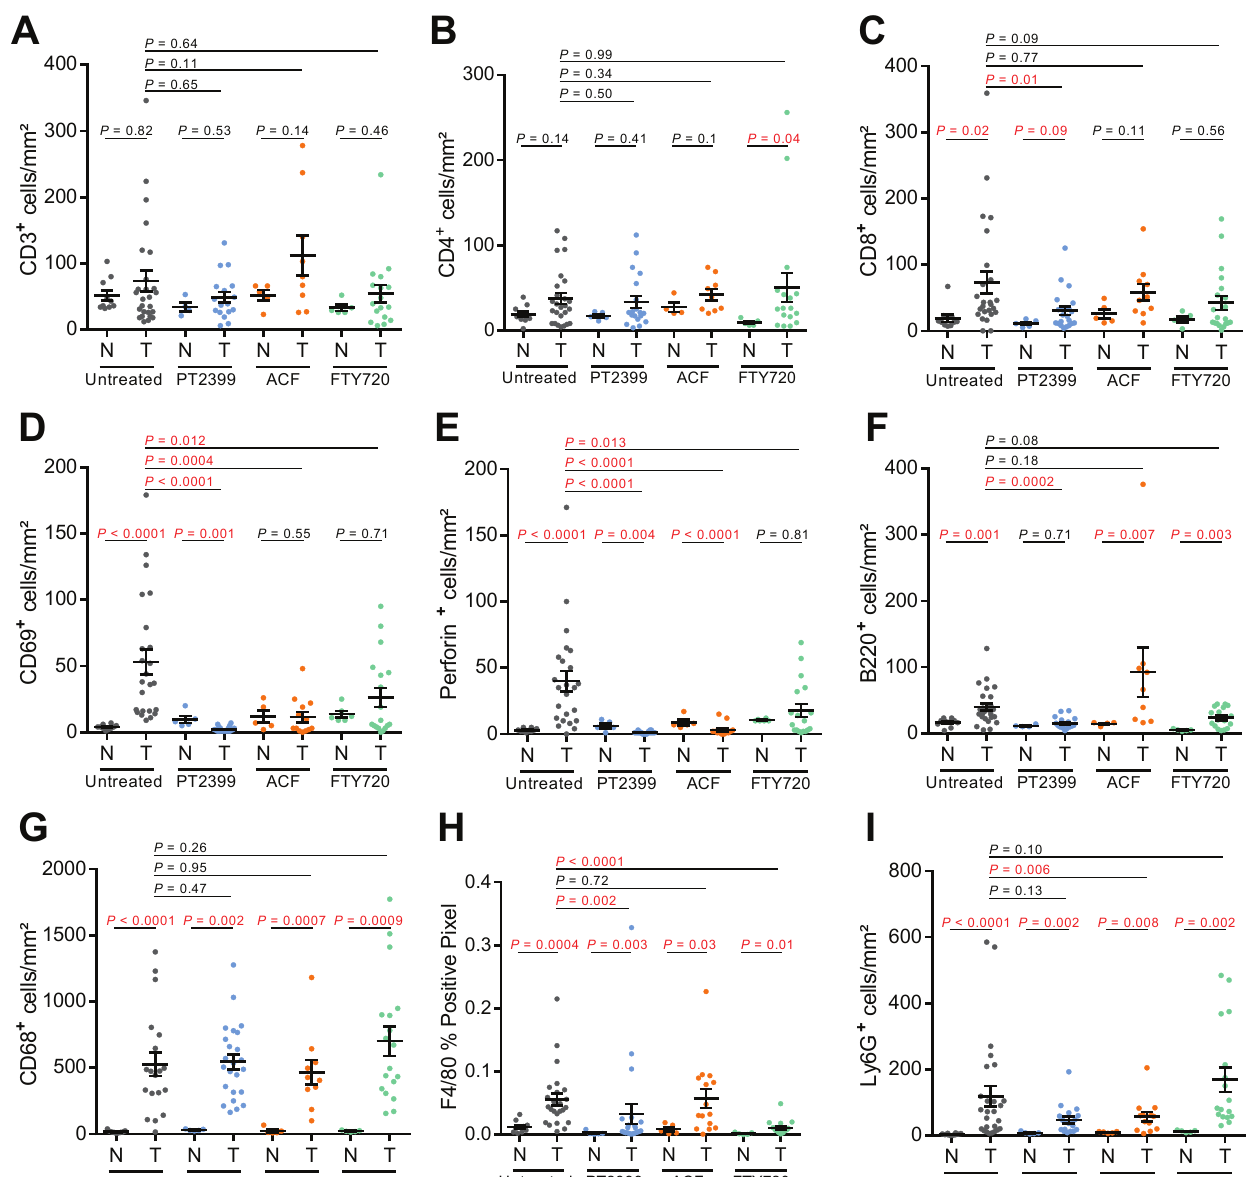
Figure 3. Analyses of the tumor immune microenvironment in therapy treated mice. ( A – I ) Quantification of the densities of immunohistochemically positive cells stained with the indicated antibodies in unaffected normal renal tissue (N) and VpR ccRCC tumors (T) in untreated ( n = 19–26), PT2399 treated ( n = 17–24), ACF-treated ( n = 9–15), and FTY720-treated ( n = 17–20) animals. Mean ± SEM are shown, p -values for pairwise comparisons were calculated by Student’s t -test followed by two-sided Mann–Whitney U test without adjustments for multiple